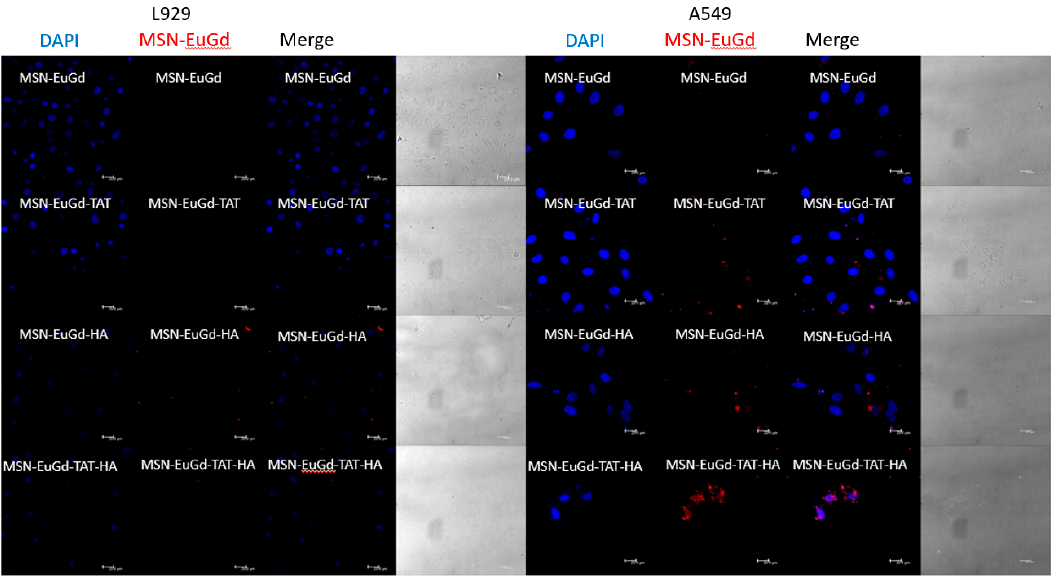
Figure 4. Confocal Laser Scanning Microscope (CLSM) image of MSN-EuGd, MSN-EuGd-TAT, MSN-EuGd-HA, and MSN-EuGd-TAT-HA incubated with L929 cell line and A549 cell line for six hours. Blue: 4',6-diamidino-2-phenylindole (DAPI), red: MSN-EuGd, scale bar: 20 μ m.